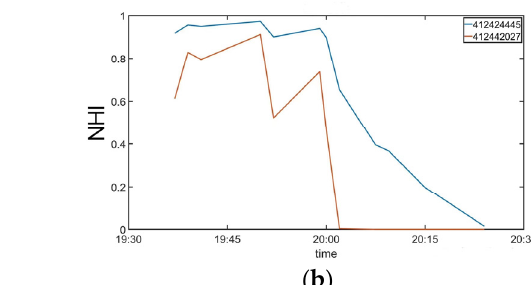
Figure 6. The crossing situation.